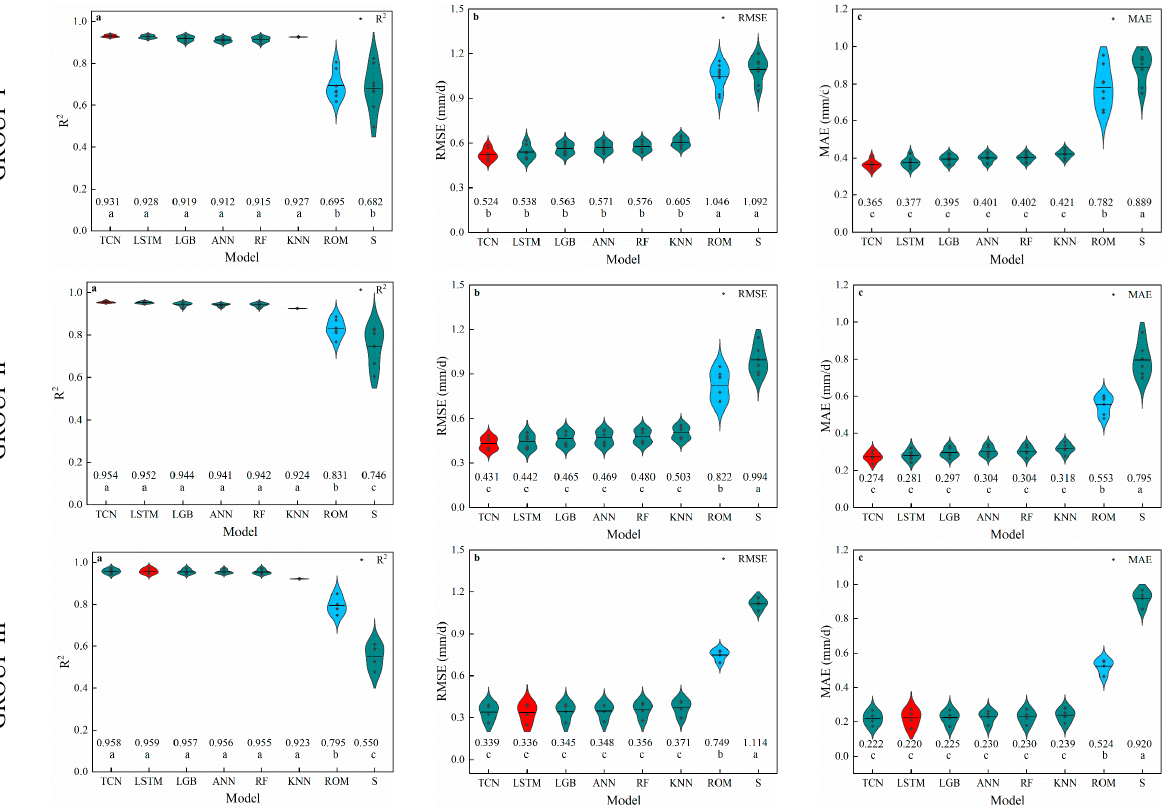
Figure 8. The performance of the humidity-based models during the second strategy: ( a ) determination coefficient (R 2 ), ( b ) root mean square error (RMSE), and ( c ) mean absolute error (MAE).